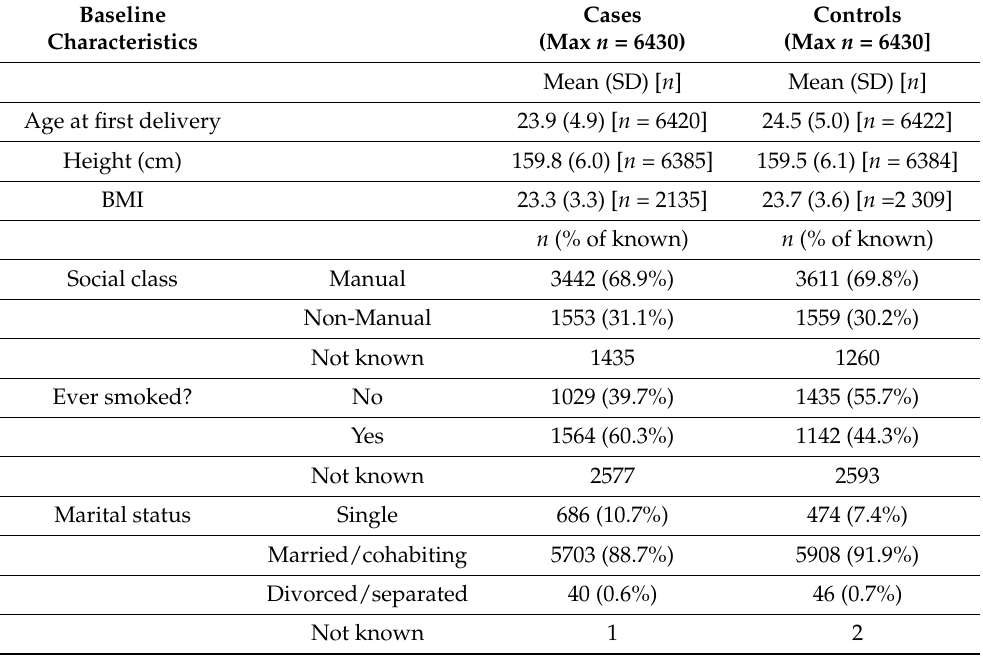
Table 1. Comparison of baseline characteristics between cases and controls at the time of first